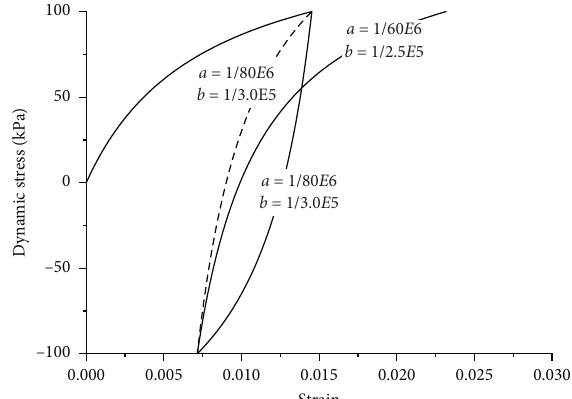
Figure 11: The combined effect of parameters a and b on the stress- strain curve.